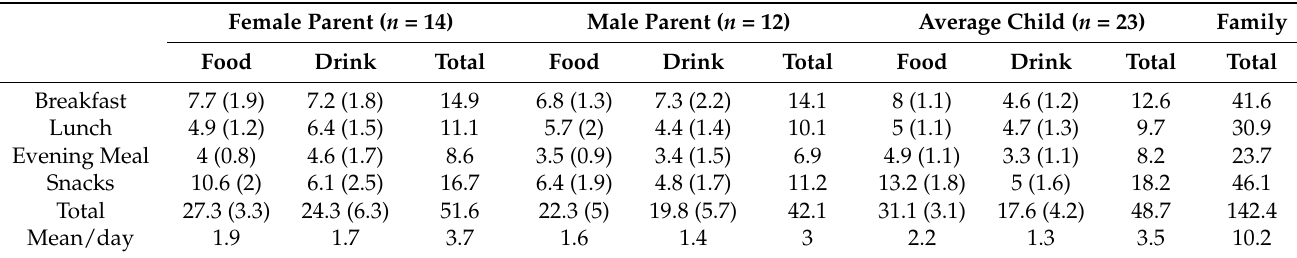
Table 4. Average swaps over 14 days for each family member separated by type (food or drink) and meal (breakfast, lunch, evening meal, and snacks). Data are average per a single child where a family has more than one child. Mean (range) number of days data per family for each stage were 13.86 (12–14) for baseline, 13.93 (13–14) for intervention, 14 (14) for immediate follow-up, and 14 (14) for one year